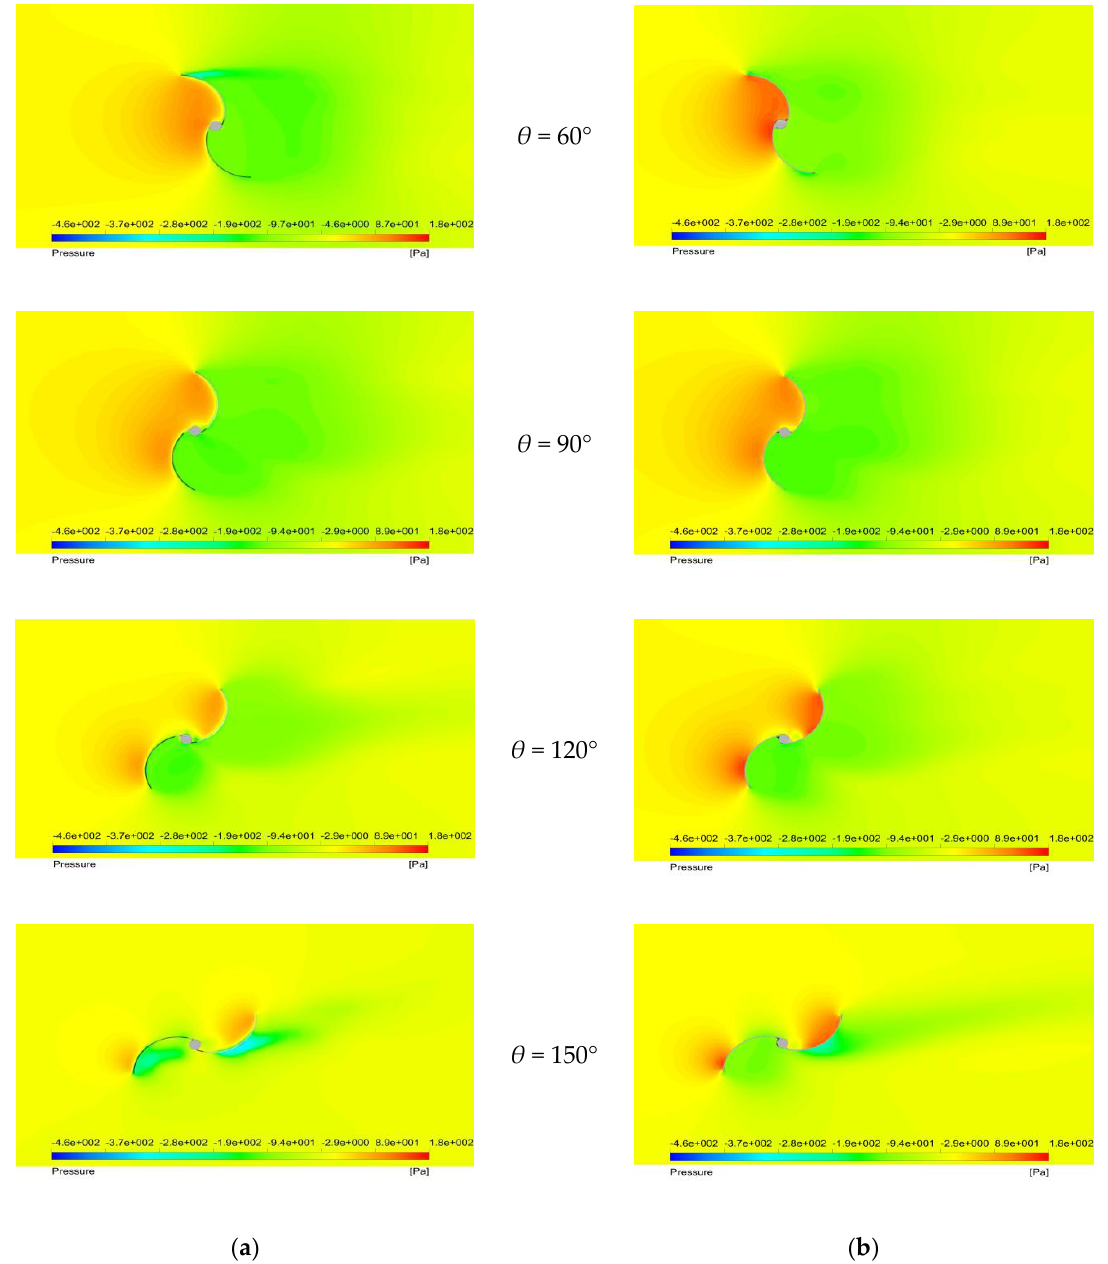
Figure 20. Pressure distributions at an air velocity of 15.8 m / s around ( a ) the IceWind turbine and ( b ) the Savonius wind turbine.